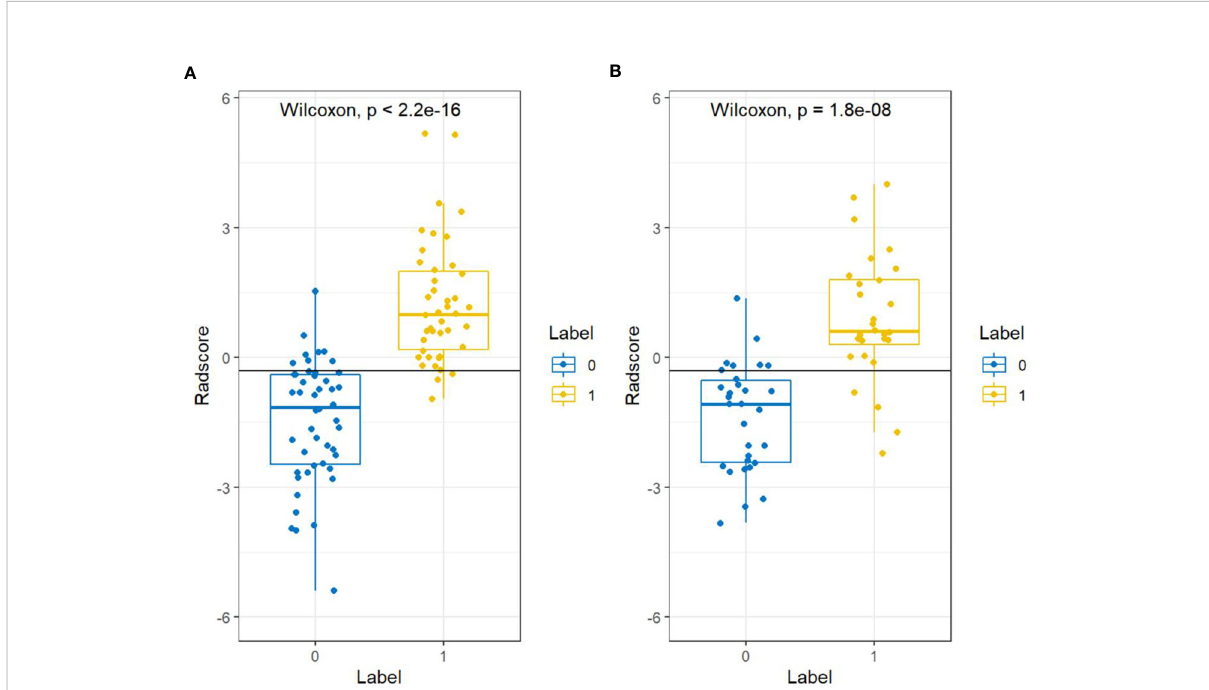
FIGURE 5 Cross-validation results for the training groups (A) and validation groups (B) . “ 0 ” represents the normal bone mass group and “ 1 ” represents the abnormal bone mass